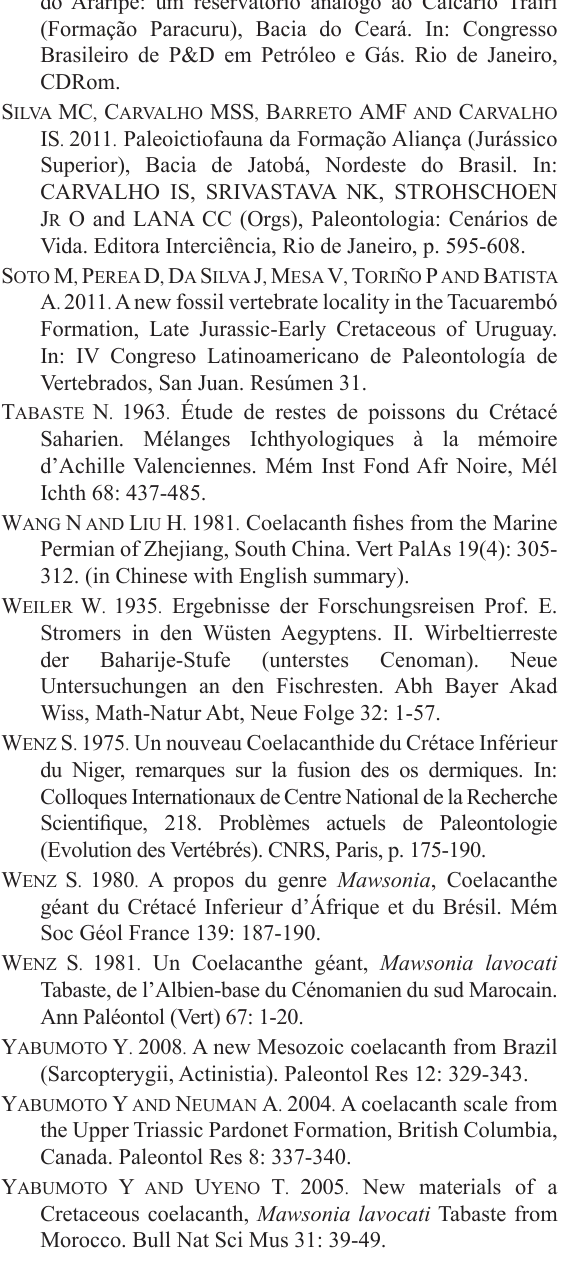
Table SI - Occurrences of Mawsoniidae. NDA = no data